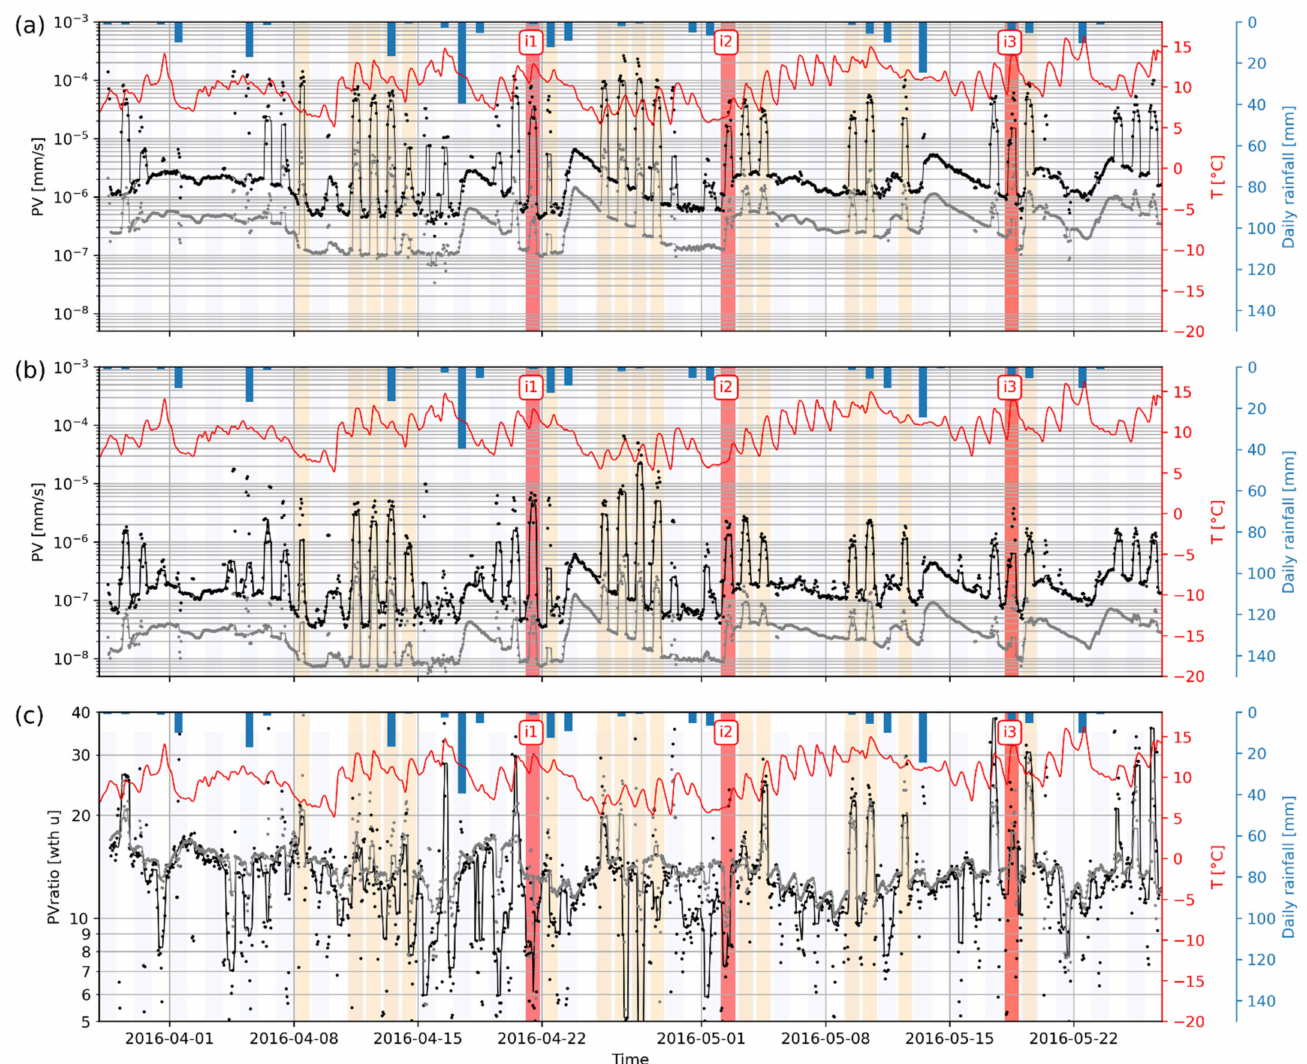
Figure A2. Particle Velocity (PV) monitoring over time for sensor BOECA ( a ) and BOREF ( b ) east channel. Sensor location is shown in Figure 1b. Continuous lines show the rolling median computed on 12 h long windows. Seismic records have been filtered around column’s mode f 0 in the [8–12 Hz] frequency band. For each 1 h slice, maxPV is shown in black, and stdPV is drawn in grey. Air temperature on-site is shown as red curve, and daily rainfall is shown as blue bars (downwards axis). Reinforcement work stages are shown in the background: drilling days (light orange) and grout injection (red). PV ratio between BOECA and BOREF is shown in ( c ), both for maxPV (black) and stdPV (grey). Y-axes for PV are